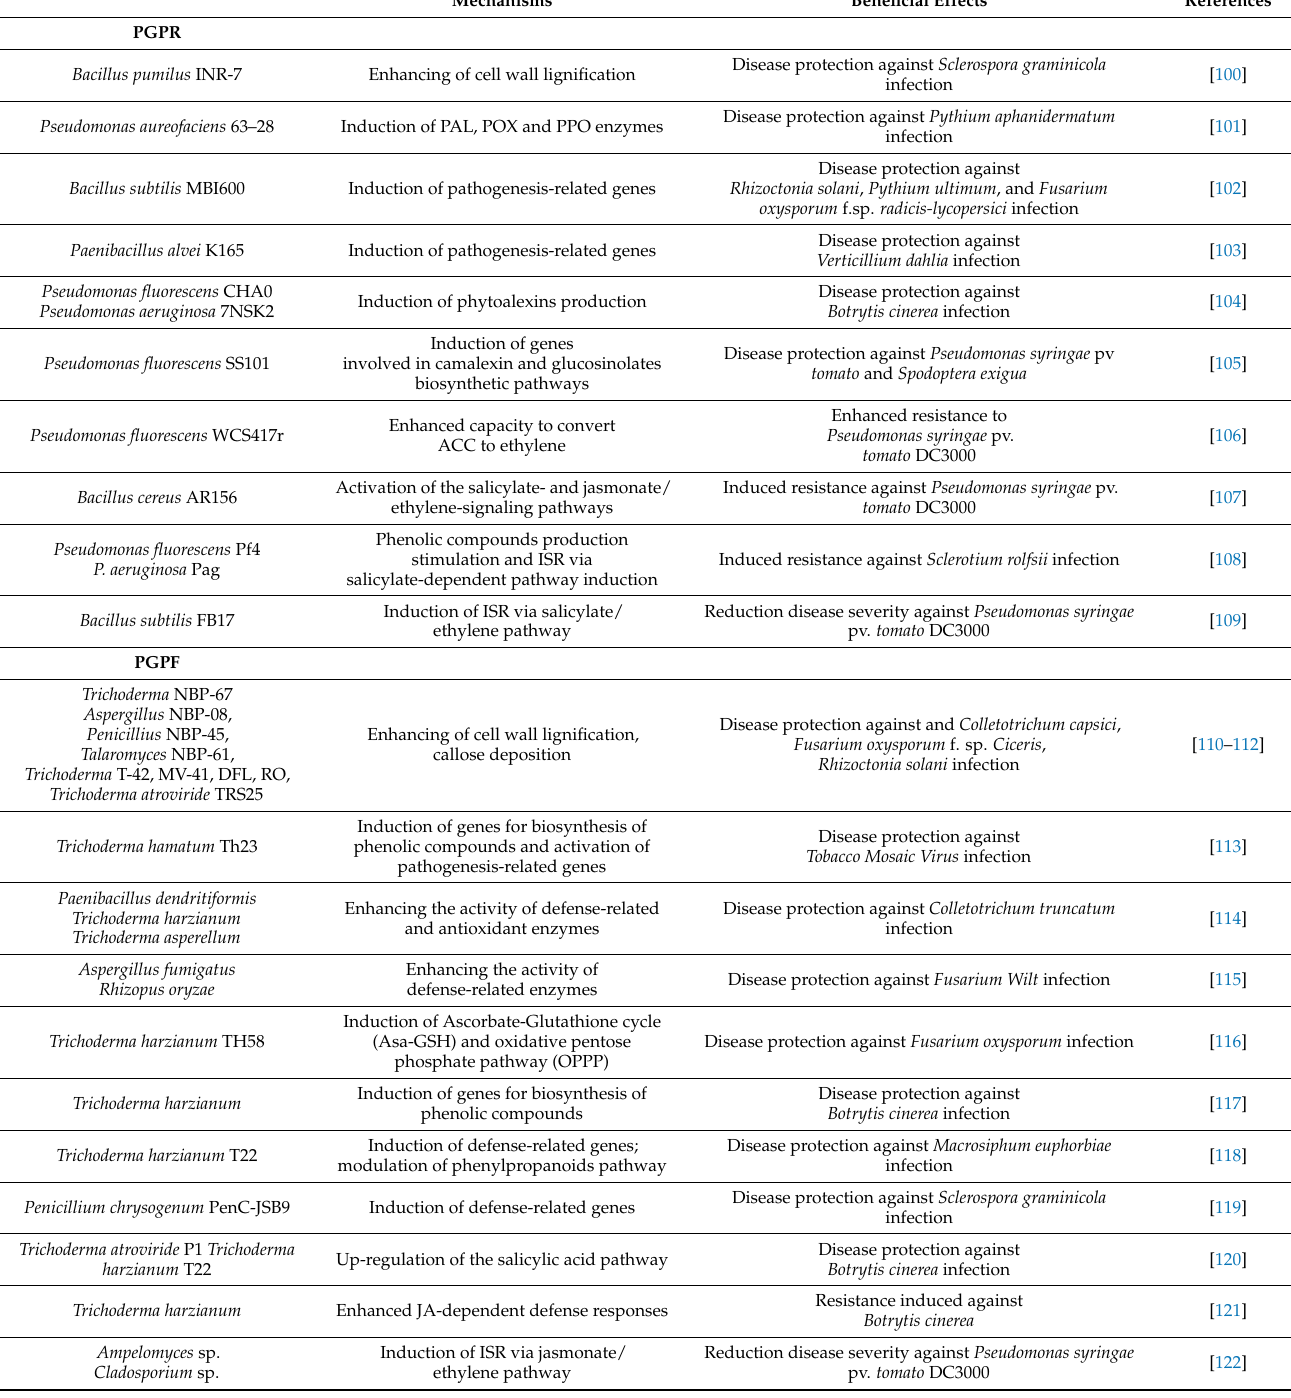
Table 2. Role of PGPMs in induced systemic